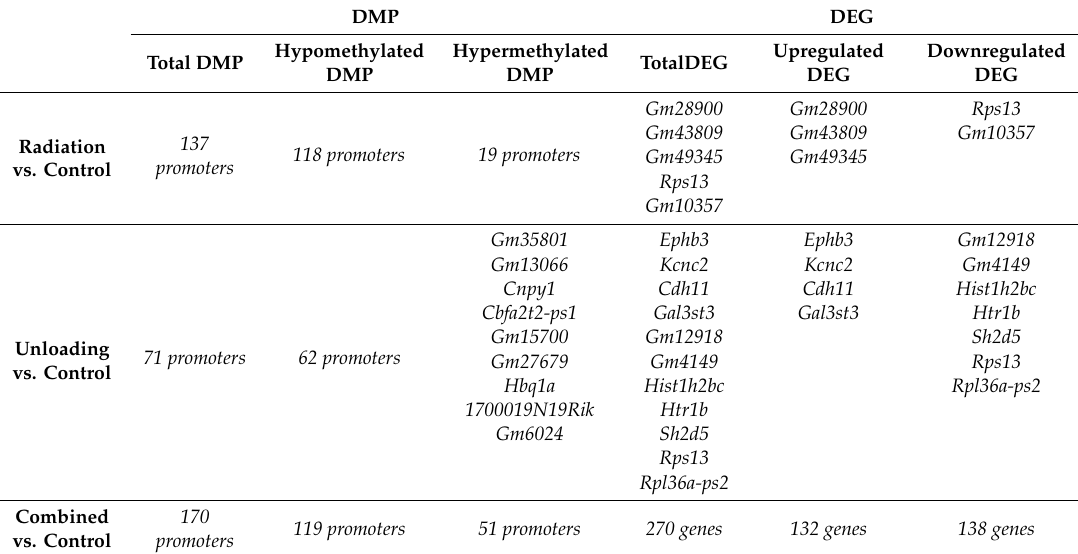
Combined vs. Control Table 2. Gene list of overlapping di ff erentially expressed genes (DEGs) and di ff erentially methylated promoters (DMPs) within each post-exposure condition.